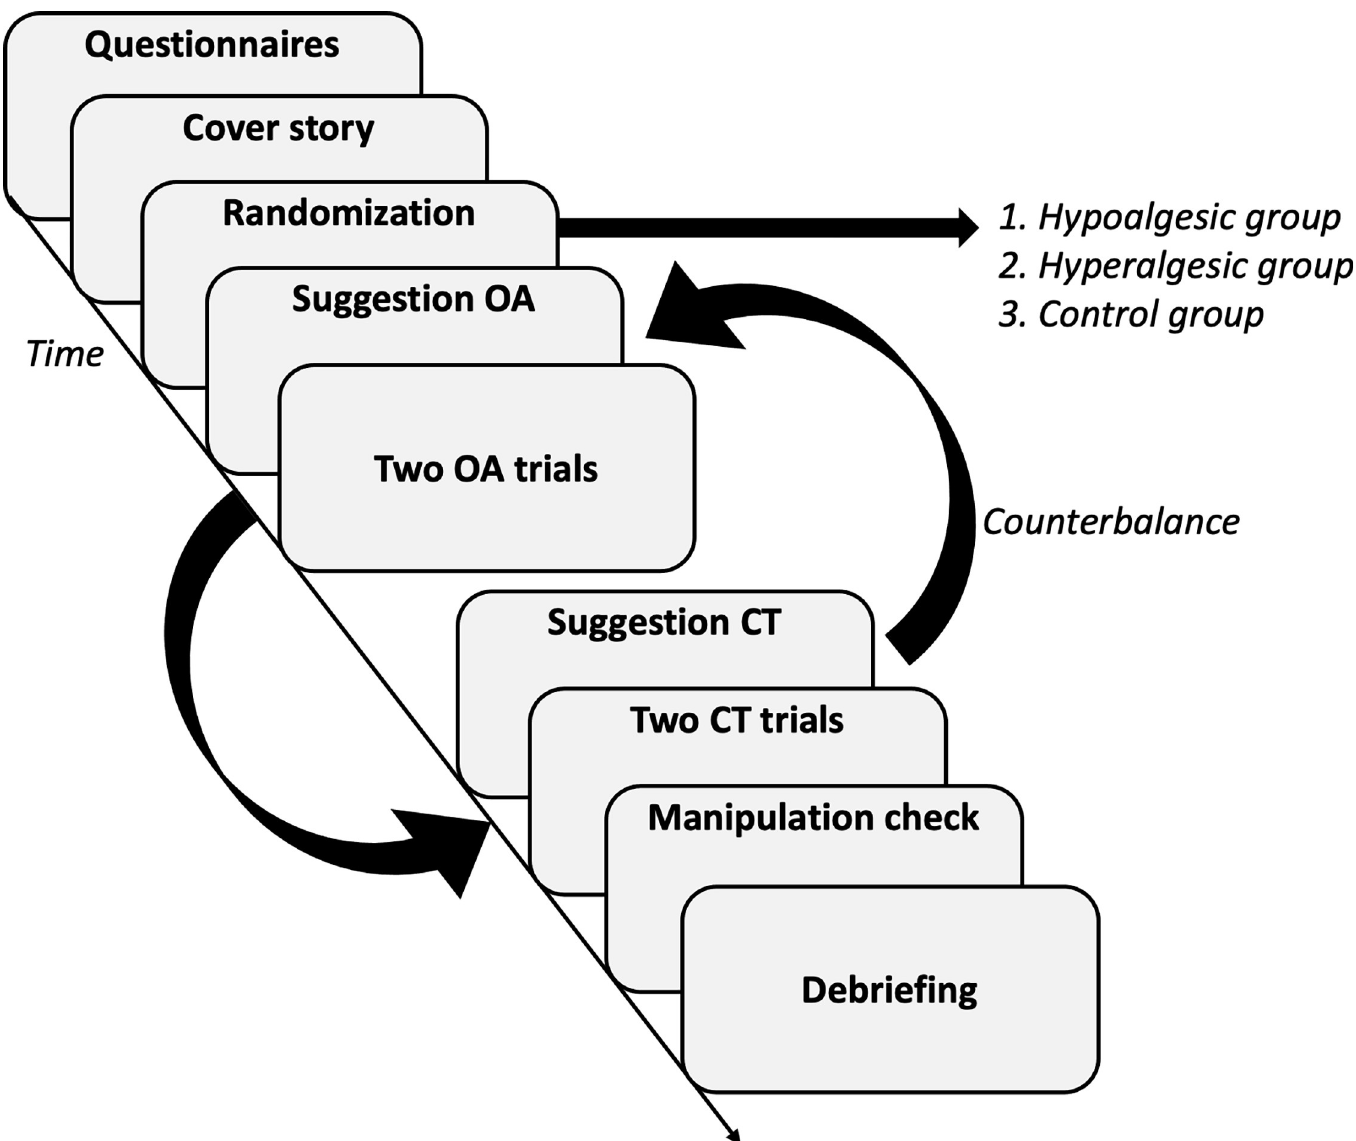
Fig 1. Study design. Before randomization, participants were instructed and a cover story was provided. Participants were told that in this study, changes in electrodermal activity (EDA) would be assessed as a measure of the autonomic nervous system during experimental heat stimuli and used to predict the perception of pain (cover story). Participants were assigned to either i) the hypoalgesic group with suggestion towards profound hypoalgesia following the temperature reduction, ii) the hyperalgesic group with verbal suggestion towards hyperalgesia following the temperature reduction (see the example above), or iii) the control group with no intervention. Regardless of the group assignment participants were exposed to two offset and two constant trials provided in a counterbalanced